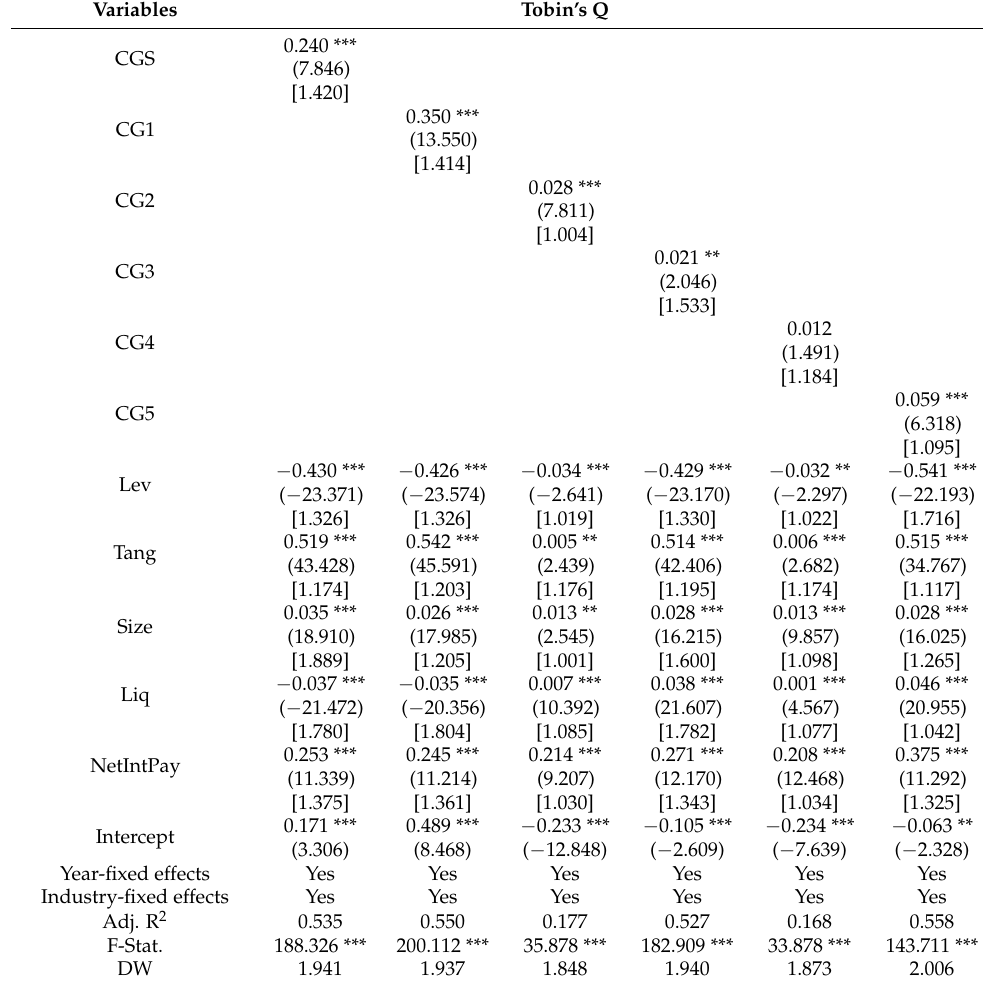
Table 4. Relationship between FV and